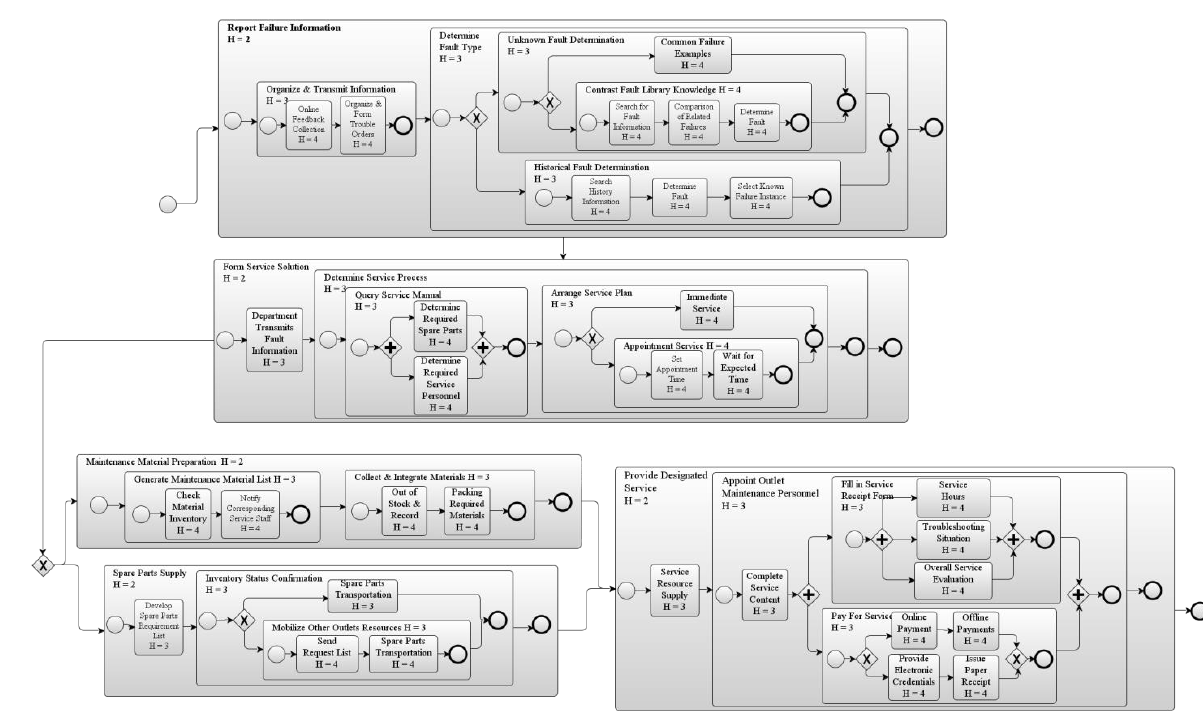
Figure 7. Air-conditioning service support BM H .